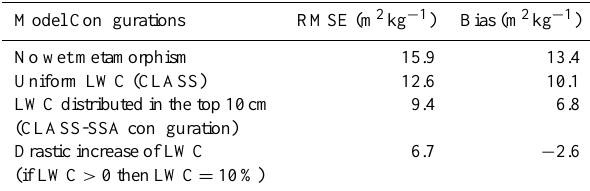
Table 1. SSA bias and RMSE for Col de Porte wet snow condi- tion data for different configurations of CLASS-SSA wet metamor-